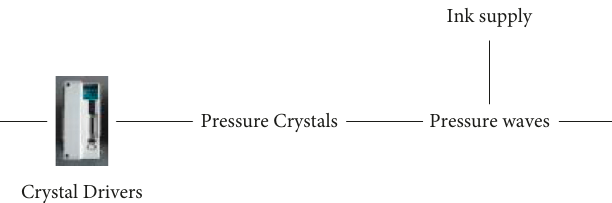
Figure 4: On-demand inkjet principle.